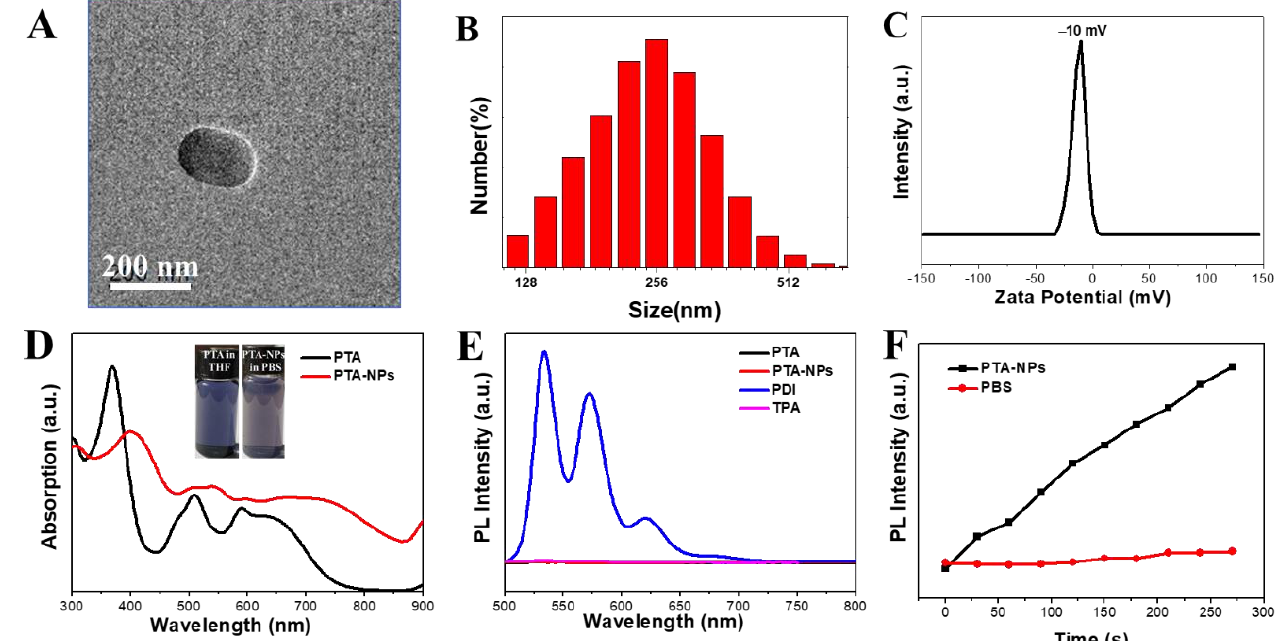
Figure 1. ( A ) TEM image of PTA-NPs; ( B ) DLS size profiles of PTA-NPs; ( C ) zeta potential of PTA- NPs; ( D ) UV/Vis absorption spectra of PTA and PTA-NPs (insert: the photographs of PTA in THF and PTA-NPs in PBS); ( E ) fluorescence spectra of PTA, PDI, TPA, and PTA-NPs; ( F ) changes in photoluminescence (PL) intensity of the characteristic peak of DCF (525 nm) with irradiation time.